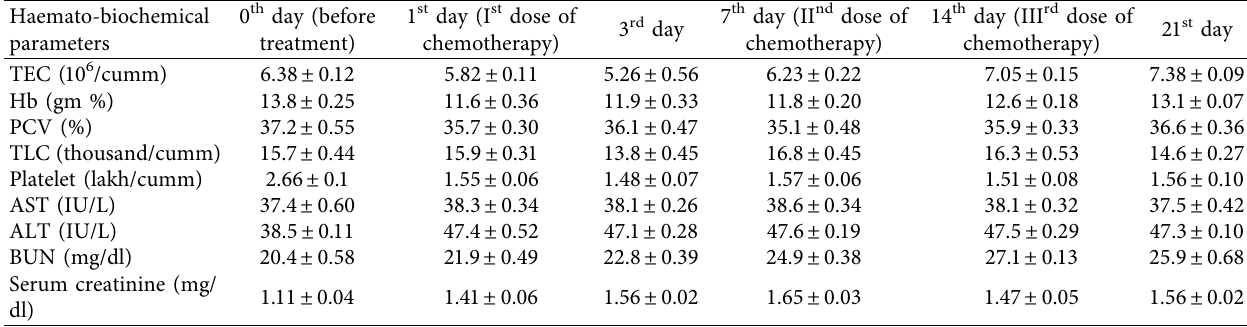
Table 1: Mean ± SE values of haemato-biochemical parameters in dogs with malignant mammary tumor prior to and after cyclophos- phamide chemotherapy in group II dogs.